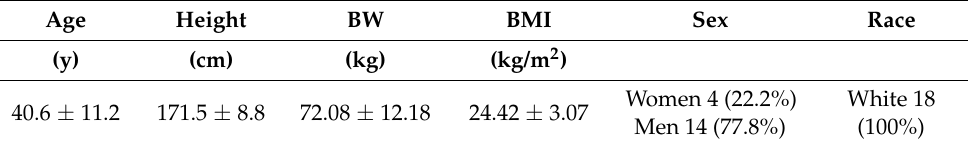
Table 4. Mean ( ± SD) baseline demographic data (N =